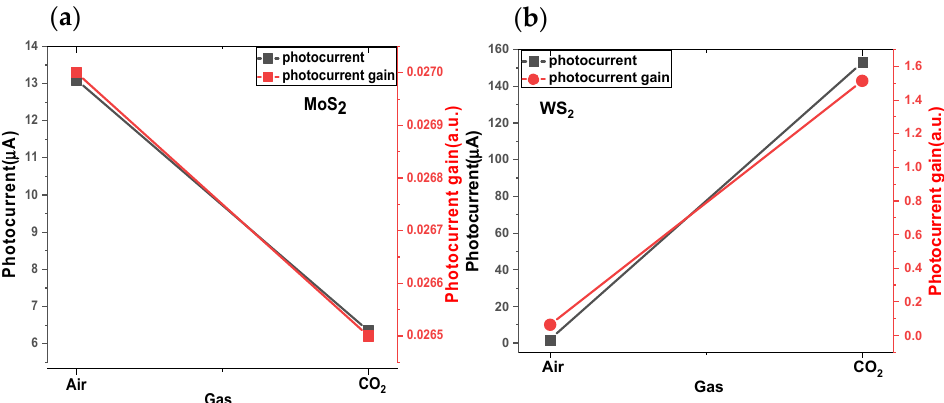
Figure 15. ( a , b ) Photocurrent and photocurrent gain of MoS 2 and WS 2 thin film under gas stimuli.